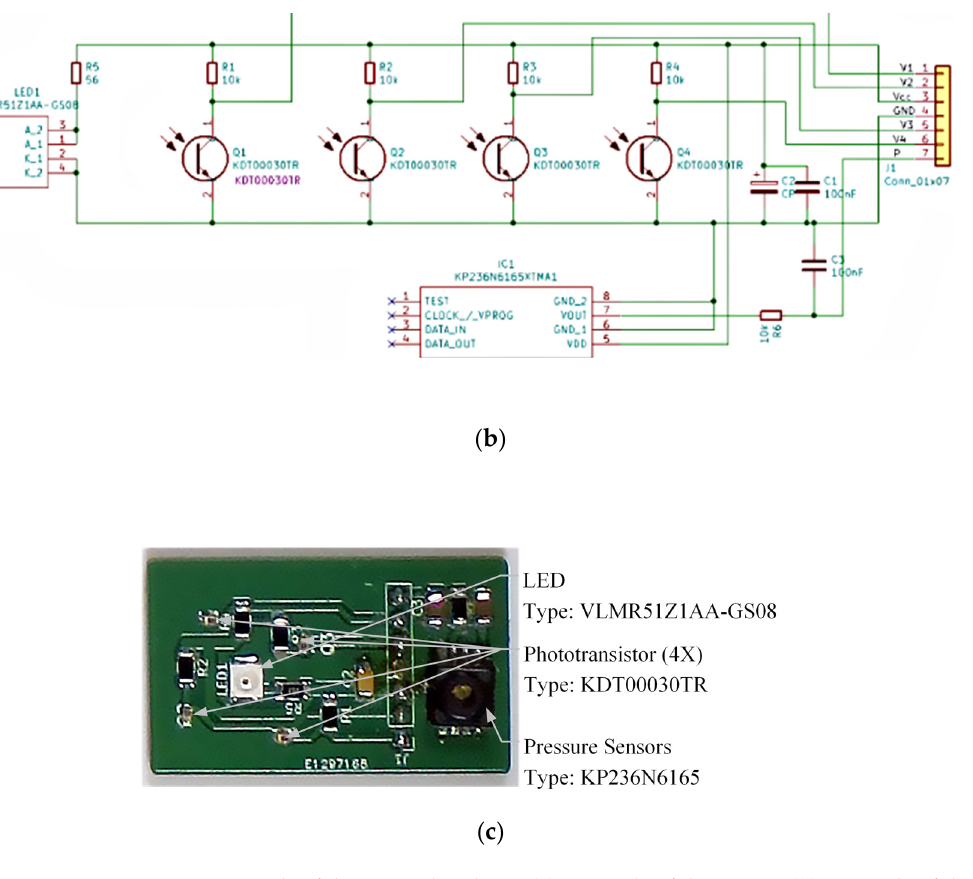
Figure 3. Details of the sensor breakout. (a) Principle of the sensor; (b) principle of the sensor; (c) the sensor breakout.